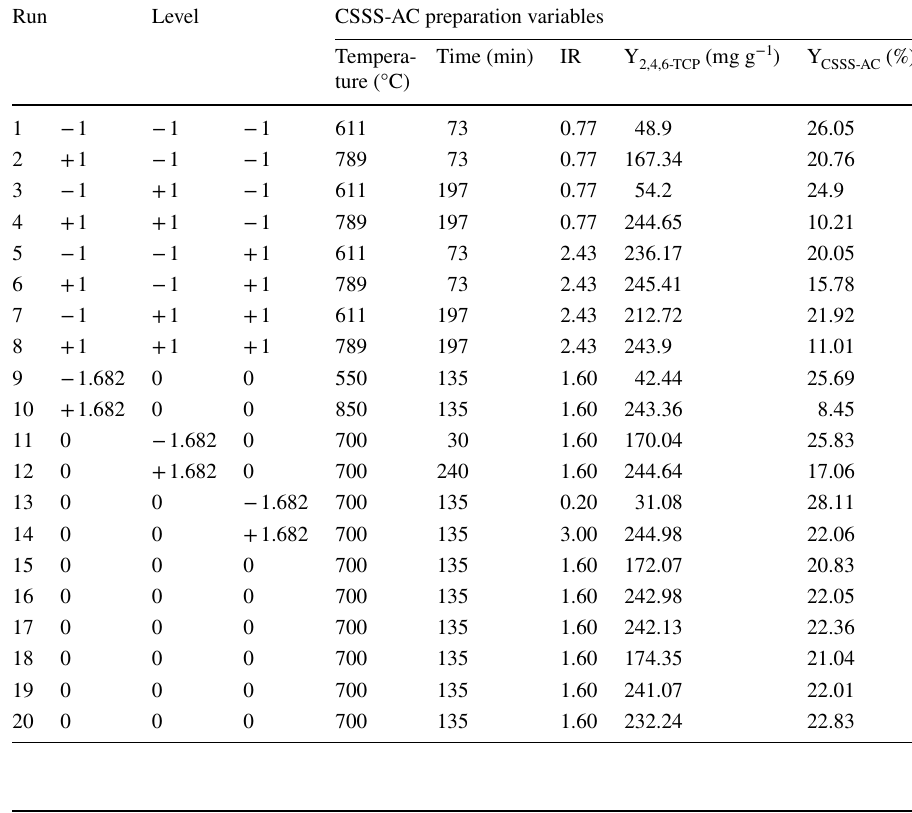
Table 1 Experimental design matrix for preparation of CSSS-AC and responses